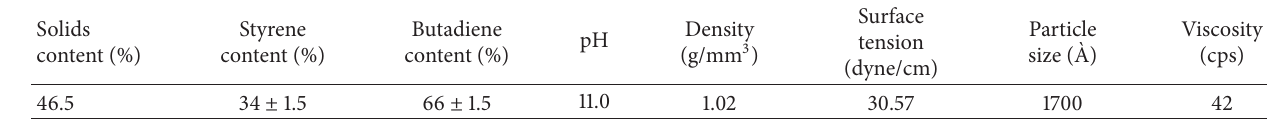
Table 4: Properties of styrene butadiene latex.